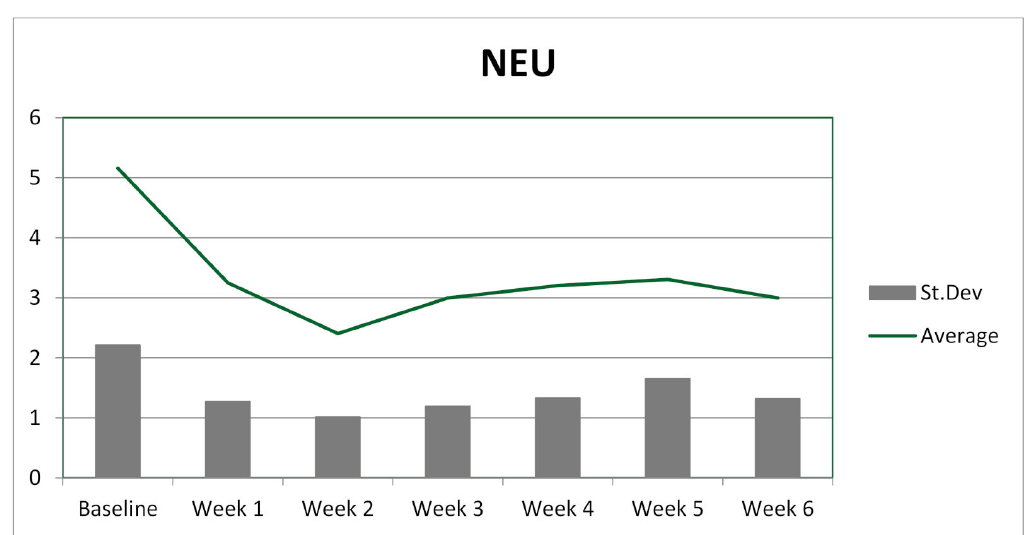
Figure A2. Nutrophil count trend during